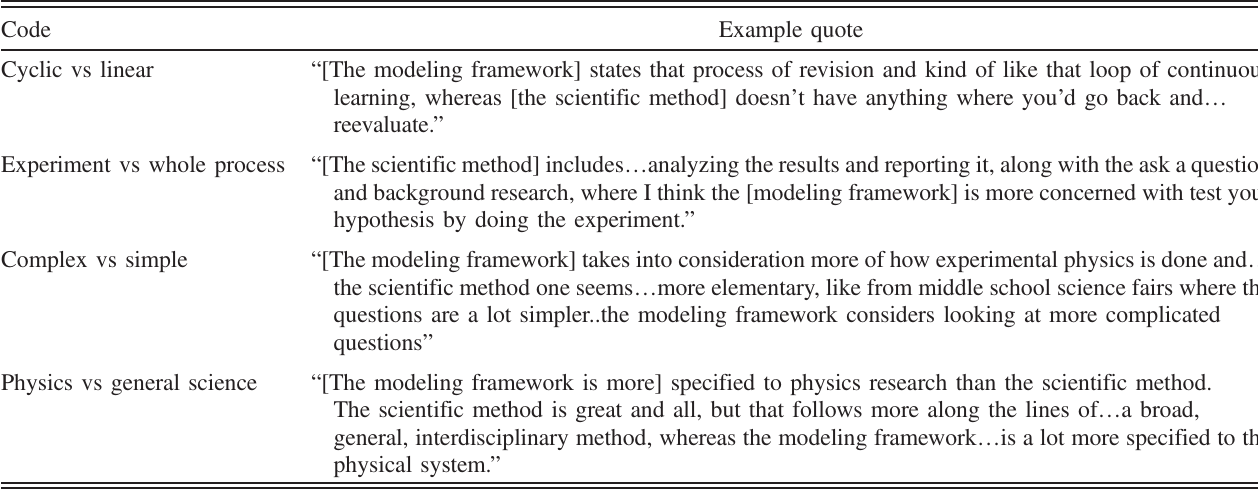
TABLE II. The four emergent codes that describe differences between the EMF and the SM that students identified, along with an example student